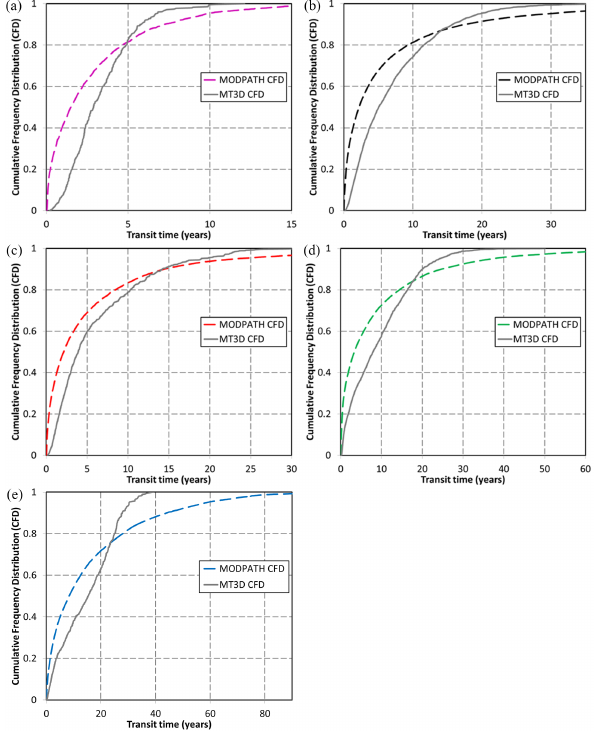
Figure 5. The CFDs of Omori (a) , Kuratau (b) , Whanganui (c) , Waihaha (d) , and Whareroa (e) watersheds calculated by MODPATH and MT3DMS (Gusyev et al.,